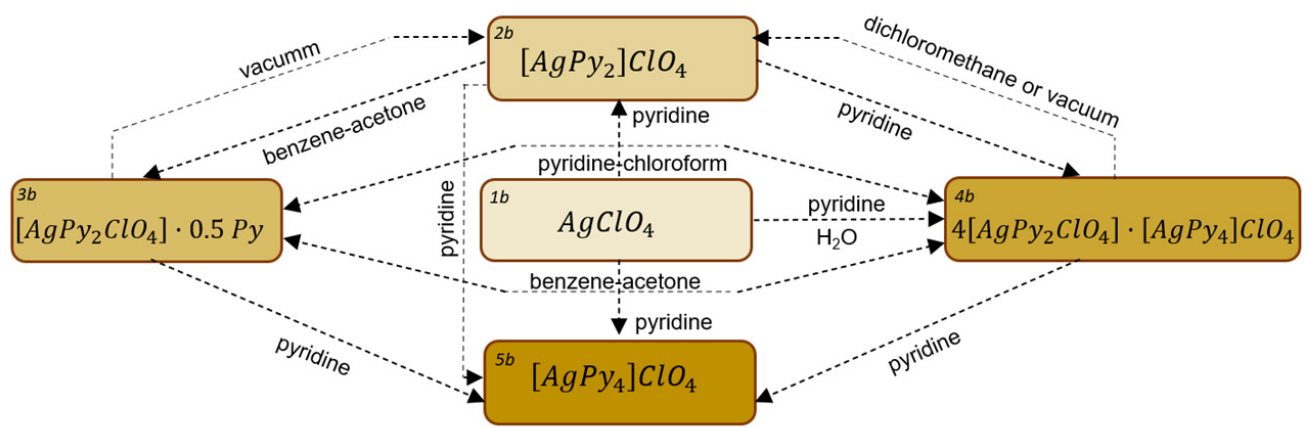
Figure 3. Interconversion scheme of perchlorate complexes